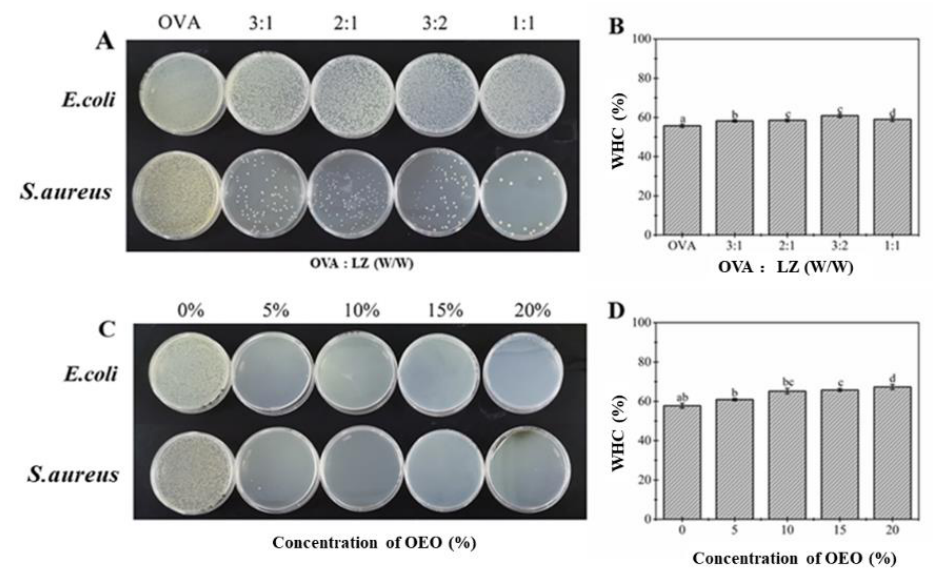
Figure 1. Effects of the addition ratio of lysozyme (LZ) ( A , B ) and oregano essential oil (OEO) ( C , D ) on the antibacterial properties and water-holding capacity of the composite gel. Different letters of a – c refer to statistically significant differences among the values ( p < 0.05).